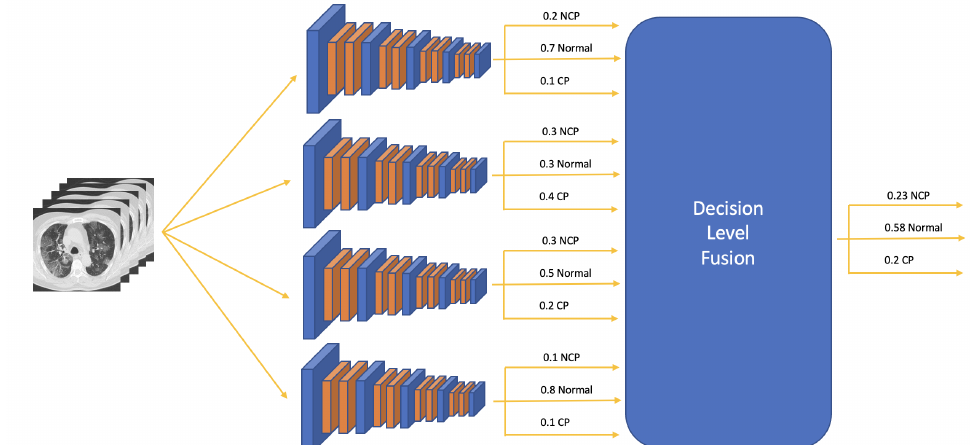
Figure 8. Ensemble classifier model. The figure shows an ensemble consisting of 4 individual models. Each model provides a distribution probability on three classes (i.e., Normal, NCP, CP). The output of the individual models is fed to a decision fusion layer that applies a voting strategy. The outcome is obtained averaging the predictions of all